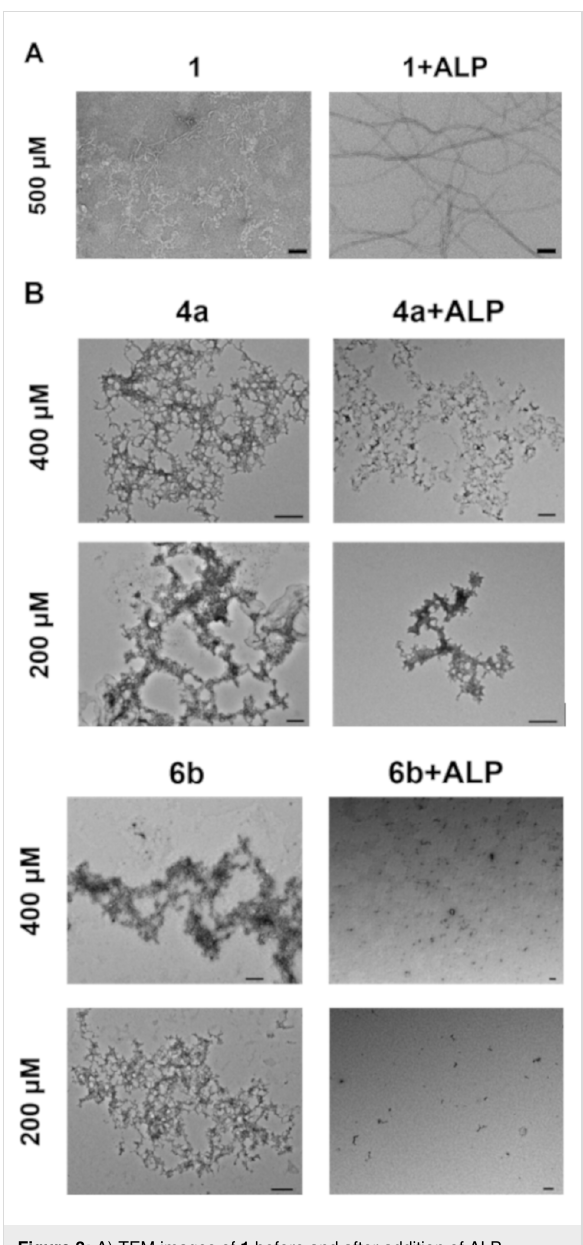
Figure 3: A) TEM images of 1 before and after addition of ALP (0.5 U/mL) in PBS buffer (pH 7.4). Scale bar is 100 nm. Figure 3A was reprinted with permission from [62] https://pubs.acs.org/doi/10.1021/ bm5010355, Copyright 2014 American Chemical Society. This